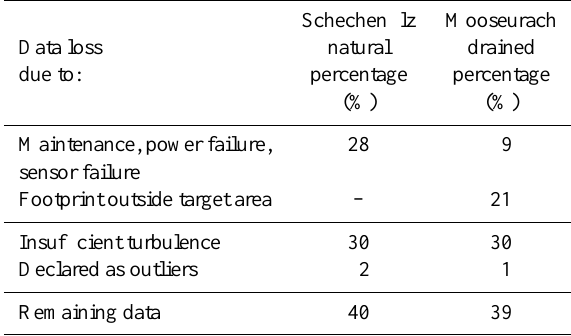
Table 2. Reasons for data loss and their percentage for both sites.